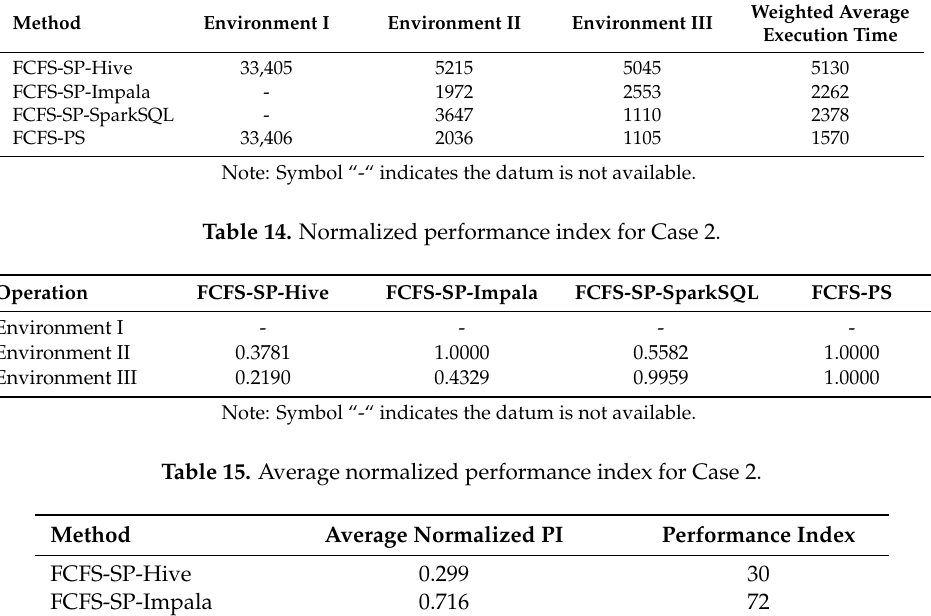
Table 15. Average normalized performance index for Case 2.